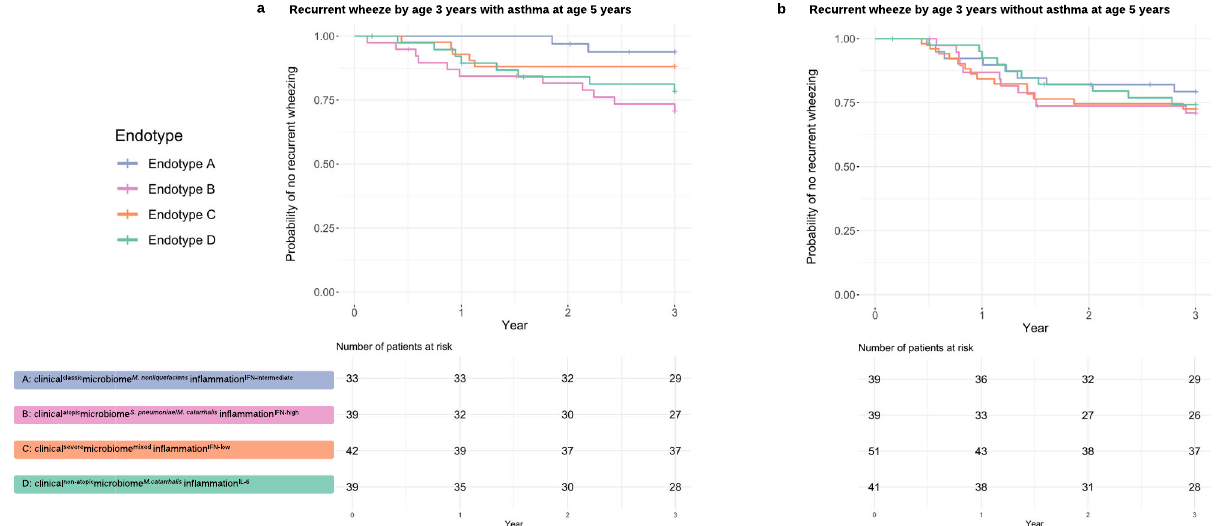
Fig. 6 Kaplan – Meier curves for development of recurrent wheeze by age 3 years, according to respiratory syncytial virus bronchiolitis endotypes. a Recurrent wheeze by age 3 years with asthma at age 5 years. Overall, the survival curves signi fi cantly differed across the endotypes (P log-rank = 0.049). Compared with endotype A (clinical classic microbiome M.nonliquefaciens in fl ammation IFN-intermediate ) infants, the rate of developing recurrent wheeze by age